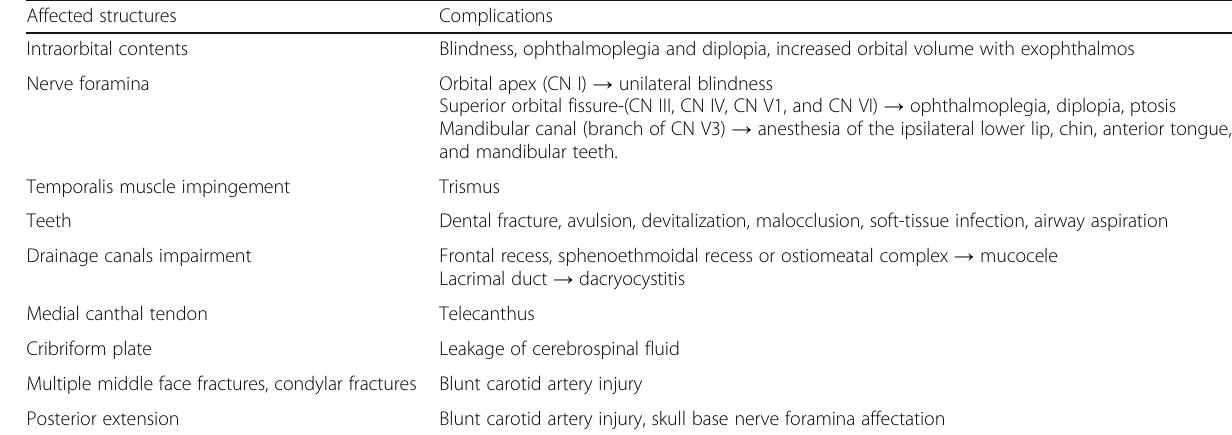
Table 1 Facial fractures complications Affected